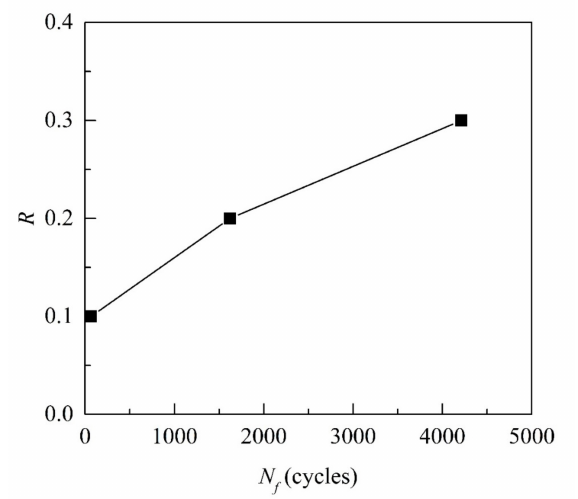
Figure 6. The effect of stress ratios on fatigue life (Single crack specimens, σ max / σ c = 0.76).